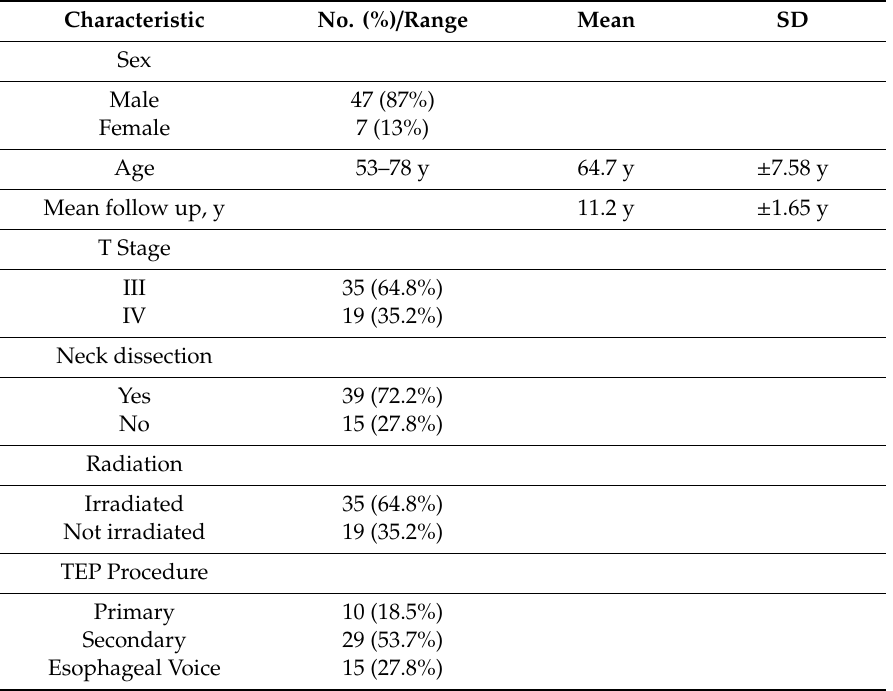
Table 1. Demographic and clinical